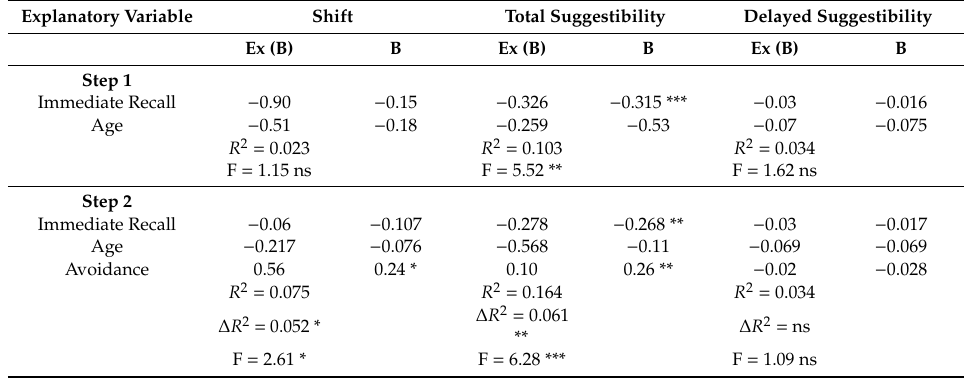
Table A2. Hierarchical linear regression models for shift, total suggestibility, and delayed suggestibility ( n =